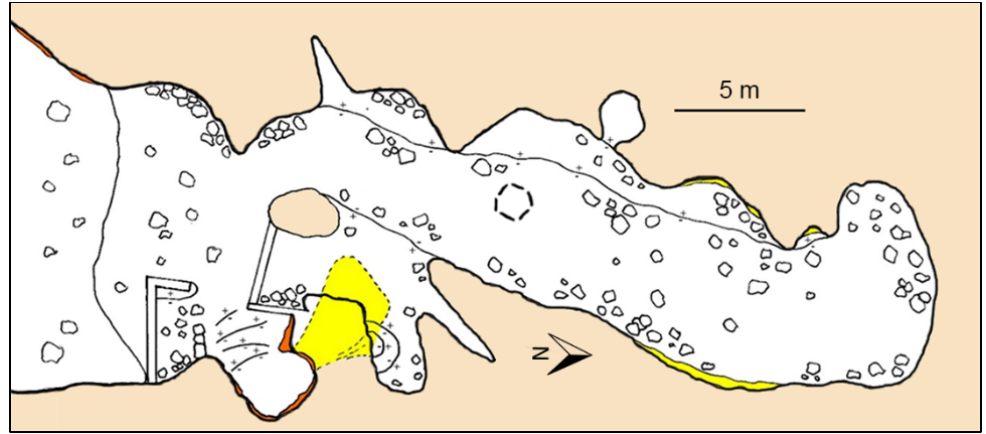
Figure 18. Plan view of the cave. Bold dashed line: hole in the ceiling; solid line: areas situated at lower levels; yellow: shell-rich deposits, sometimes with uncertain limits (light dashed line); orange: vertebrate breccias visible on the walls. Cave relief was performed on 27 September 2021 by two of us (ARe and GMi).